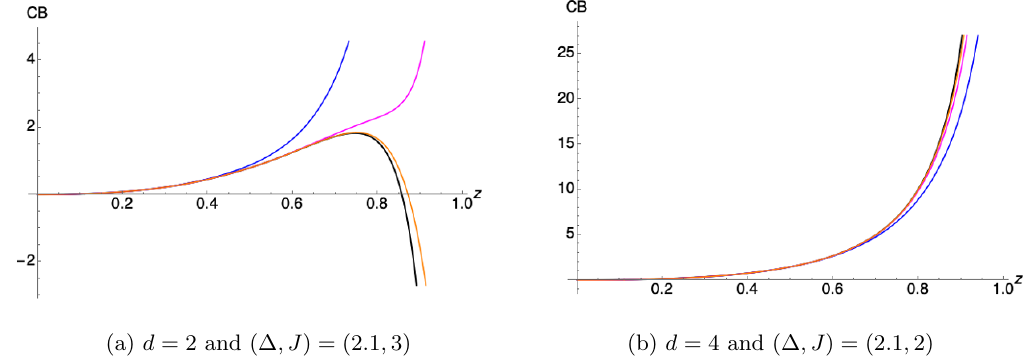
Figure 1 . Numerical match of (2.31) with known 2 and 4-dimensional conformal blocks in [2] for each ((cid:1) ; J ) and a (s) = b (s) = 0. We have also set z = (cid:22) z in the horizontal axis. The black curves correspond to the conformal blocks in [2] and the blue, pink and orange curves correspond to the conformal block expansions given in (2.31) which are truncated at n s = 2, 4 and 6 respectively. We can see that as we increase the number of terms in the summation for Appell’s F 4 function, our result quickly approaches the known existing results given by the black